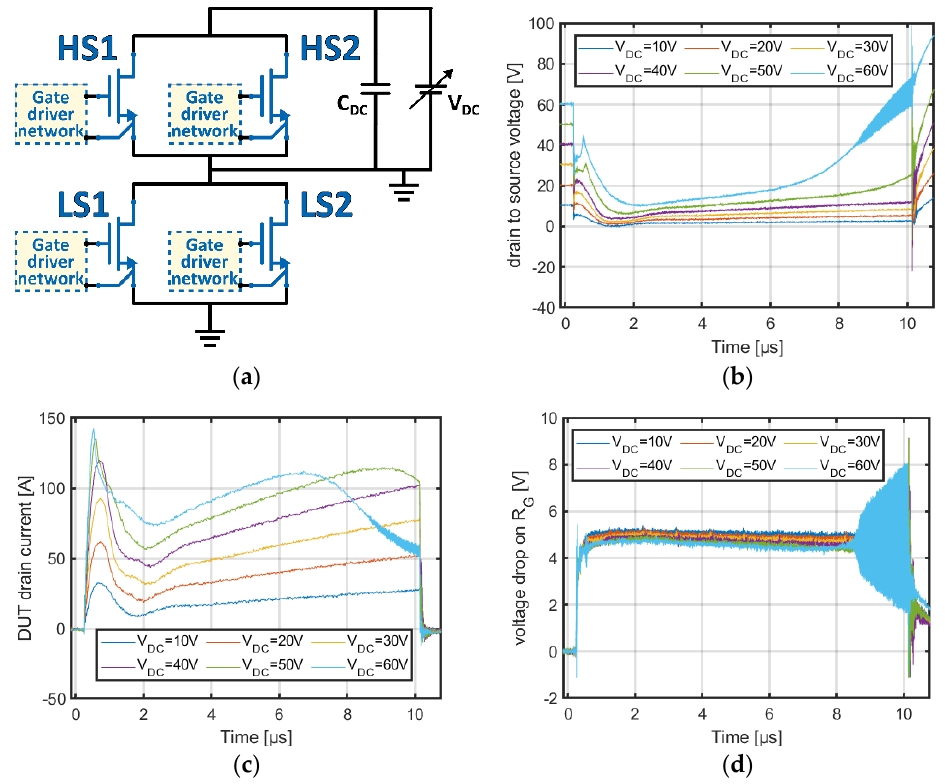
Figure 12. ( a ) Circuit schematic of the short circuit test setup adopted for the DUT_O and corre- sponding waveforms of ( b ) drain-to-source voltage, ( c ) drain current, and ( d ) voltage drop on the resistor R G .